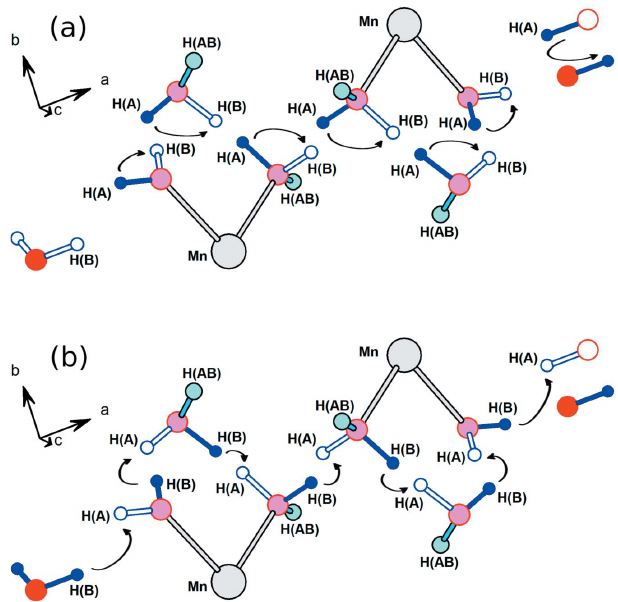
Figure 1 The two stages of the Grotthuss mechanism for proton transport. Atomic coordinates are from the neutron diffraction analysis of Capelli et al. (2013). ( a ) Reorientation of water molecules. ( b ) Proton hopping. See the text for a detailed